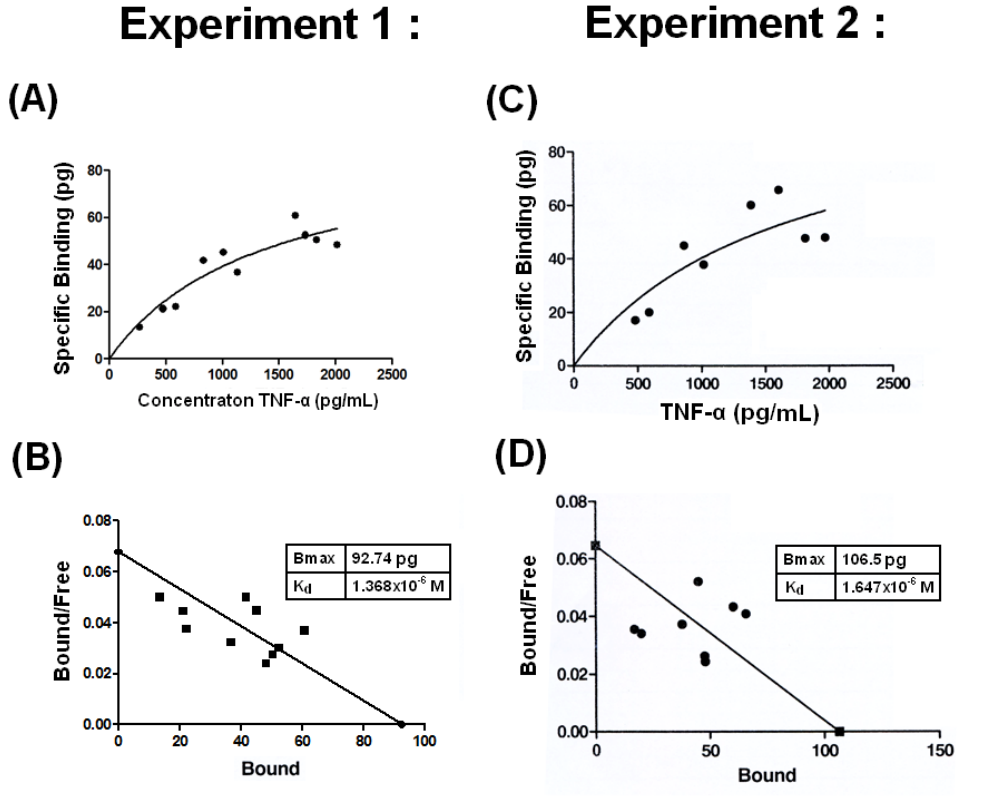
Figure 3. Binding affinity of THP for TNF- α was conducted in two independent experiments by ELISA. ( A ) and ( C ): The specific binding vs . TNF- α concentrations are plotted. ( B ) and ( D ): Y transformed curves are derived from the specific bindings of the two experiments. Bmax and K values were then calculated by Scatchard plot analysis as d described in Materials and Methods in Section